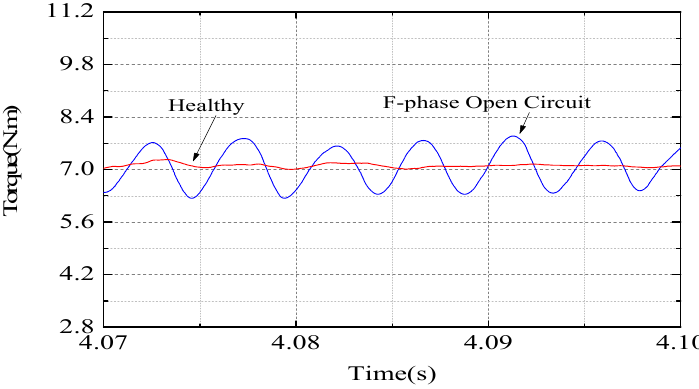
Figure 6. Torque of the motor in healthy and open circuit operation.